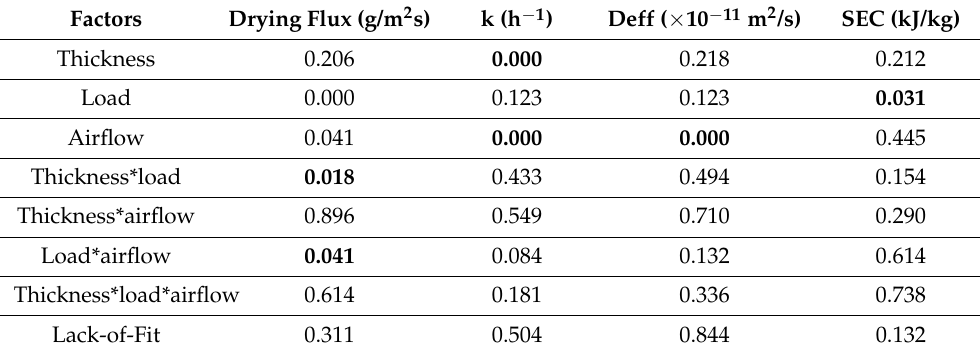
Table 2. The p -values obtained from the multifactorial ANOVA using the general linear model at a 0.05 significance level for drying